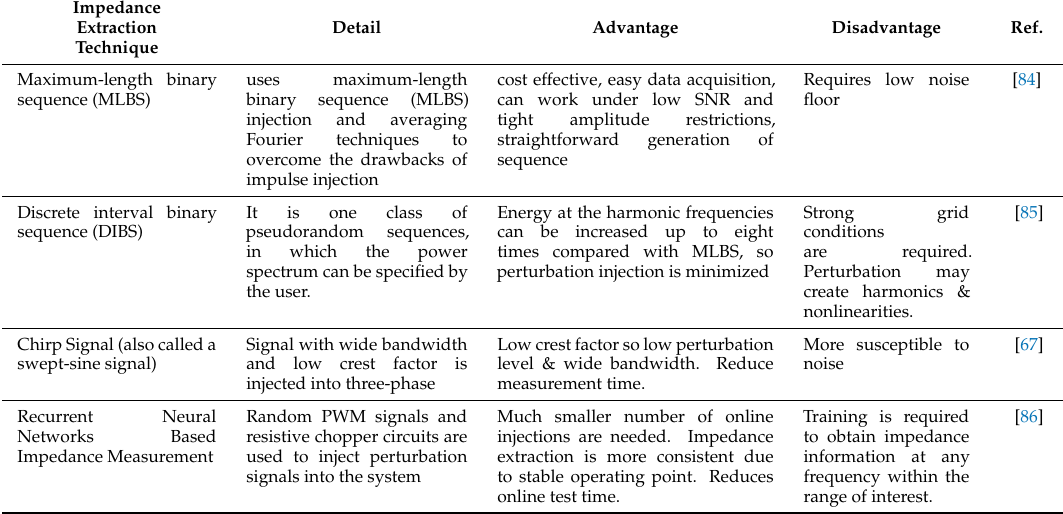
Table 4. Comparative Analysis of Different Impedance Extraction Techniques Not Involving Shunt Current